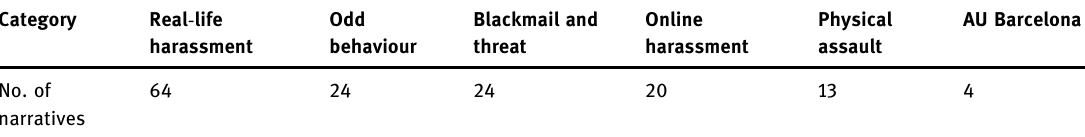
Table 2: Division of screenshots on